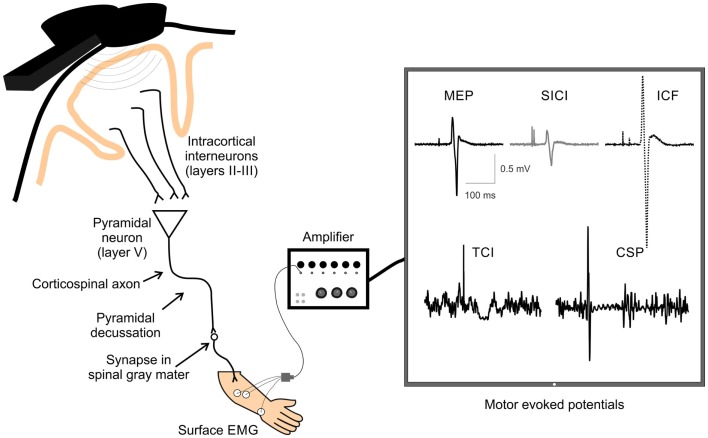
A schematic of TMS-evoked measures of single and paired-pulse corticospinal excitability. Examples of TMS-evoked measures of corticospinal excitability recorded by surface electrodes over the extensor carpi radialis (ECR) muscle. Displayed are examples of motor-evoked potential (MEP), short-interval intracortical inhibition (SICI), intracortical facilitation (ICF), transcallosal inhibition (TCI), and cortical silent period (CSP). TMS, transcranial magnetic stimulation; EMG, electromyography.